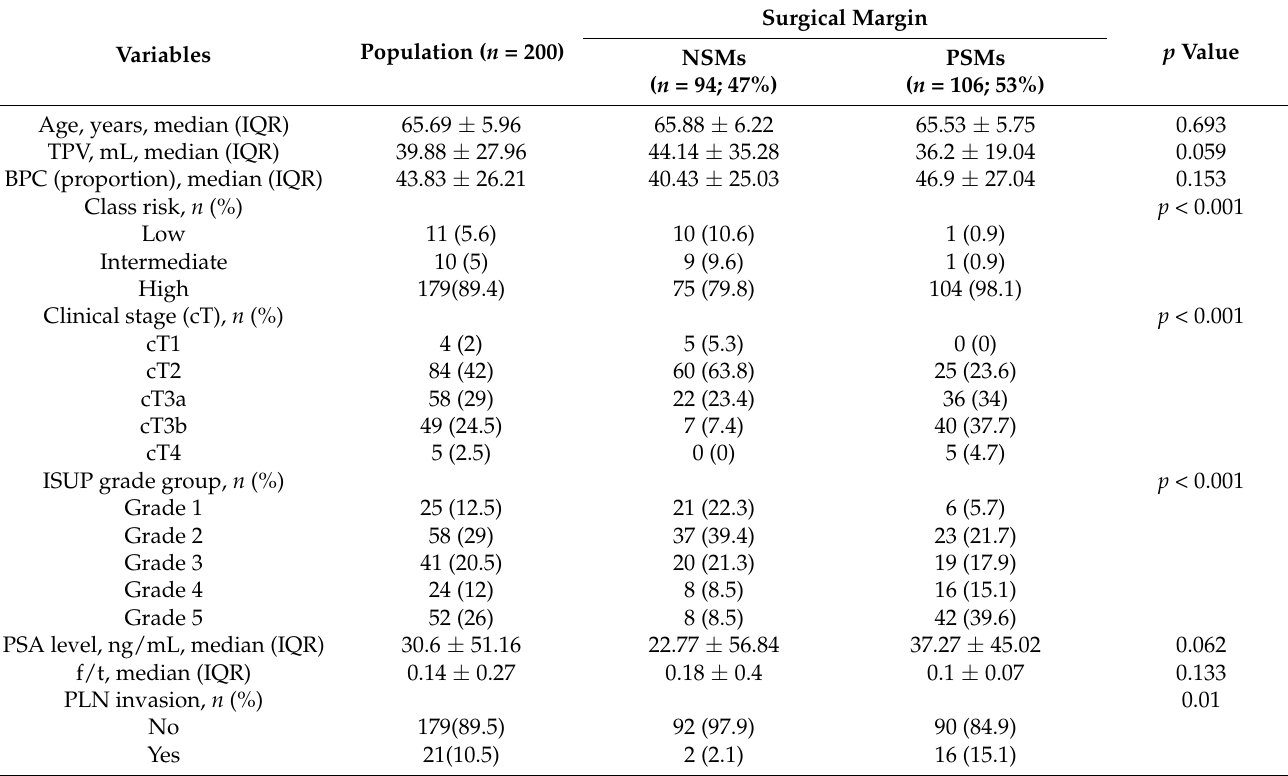
Table 1. Distribution of clinical and pathological factors in the population and subgroups of patients according to surgical margins